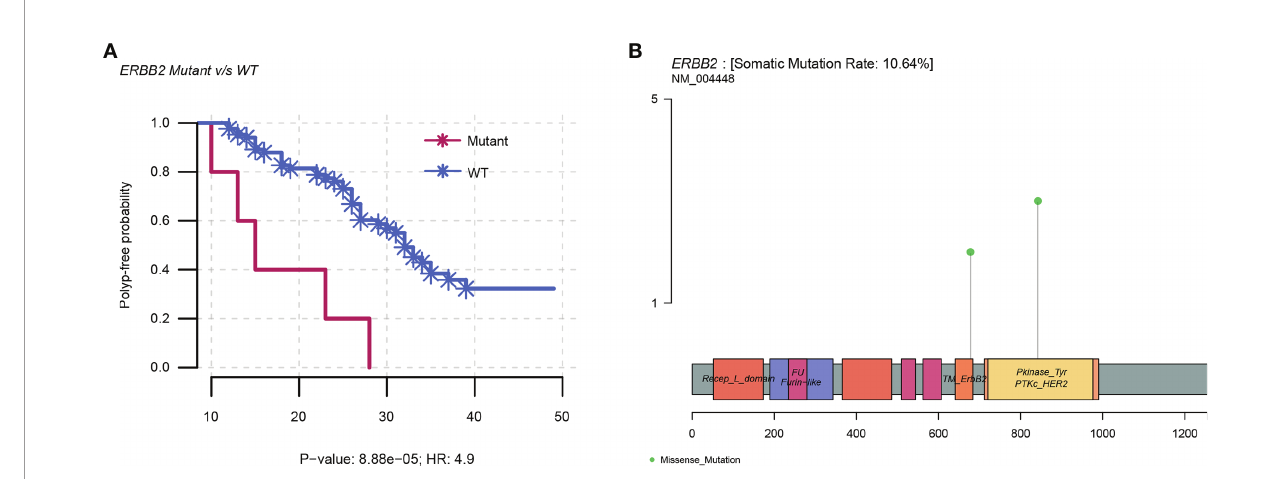
FIGURE 4 | ERBB2 mutations in the NGS cohort. (A) Kaplan – Meier plot showing an increased risk of polyp recurrence over time in the ERBB2 mutants than in the wild types, with a median polyp-free interval of 15 months compared to 26 months (P < 0.001; HR = 4.9; 95% CI = 1.9 – 12.8). (B) Linear structure of ERBB2 illustrating the region and frequency of the variants (R678Q and V842I). WT, wild type; HR, hazard